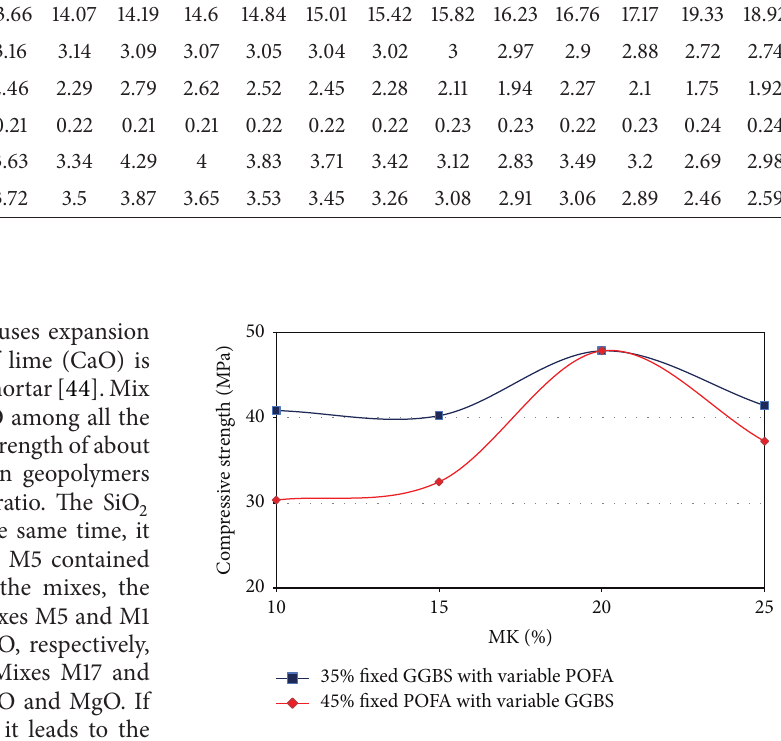
Figure 13: Effect of MK on compressive strength mixed with 45% POFA and 35%